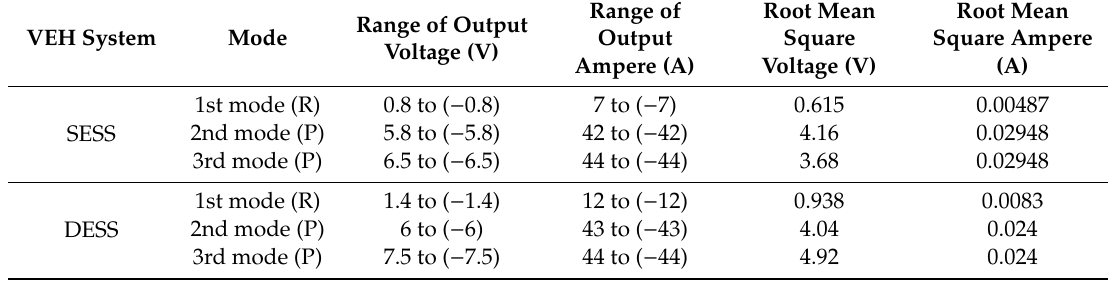
Table 5. AC testof the SESS and DESS systems ((R) represents piezo patch placed at the root, (P) represents piezo patch placed at the peak).